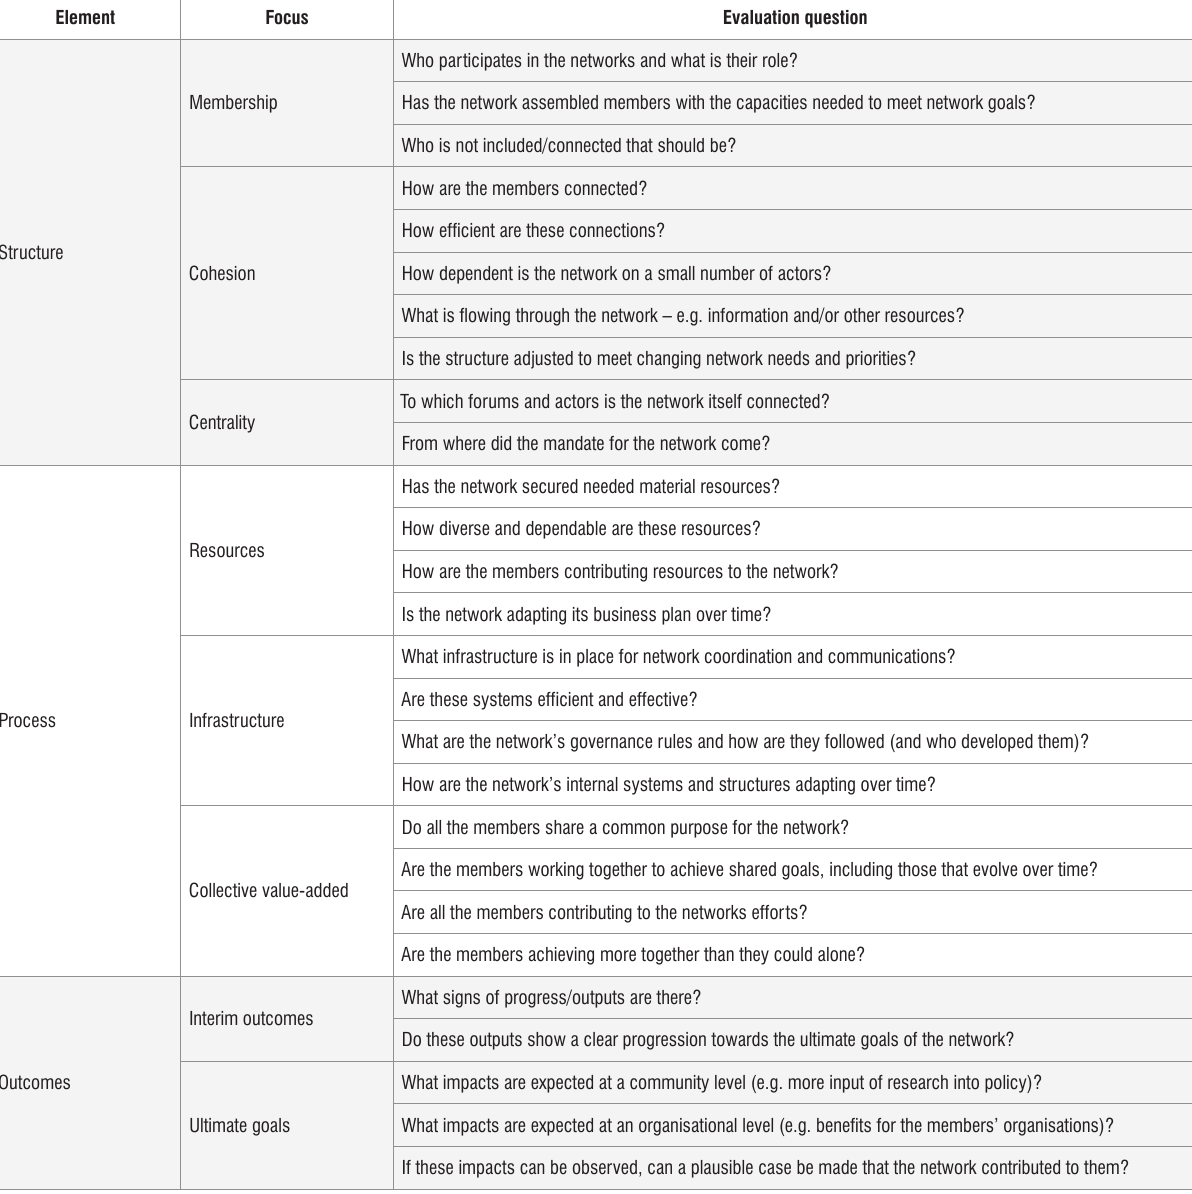
Table 1: Evaluation framework for the three network elements (structure, process and outcomes) Element